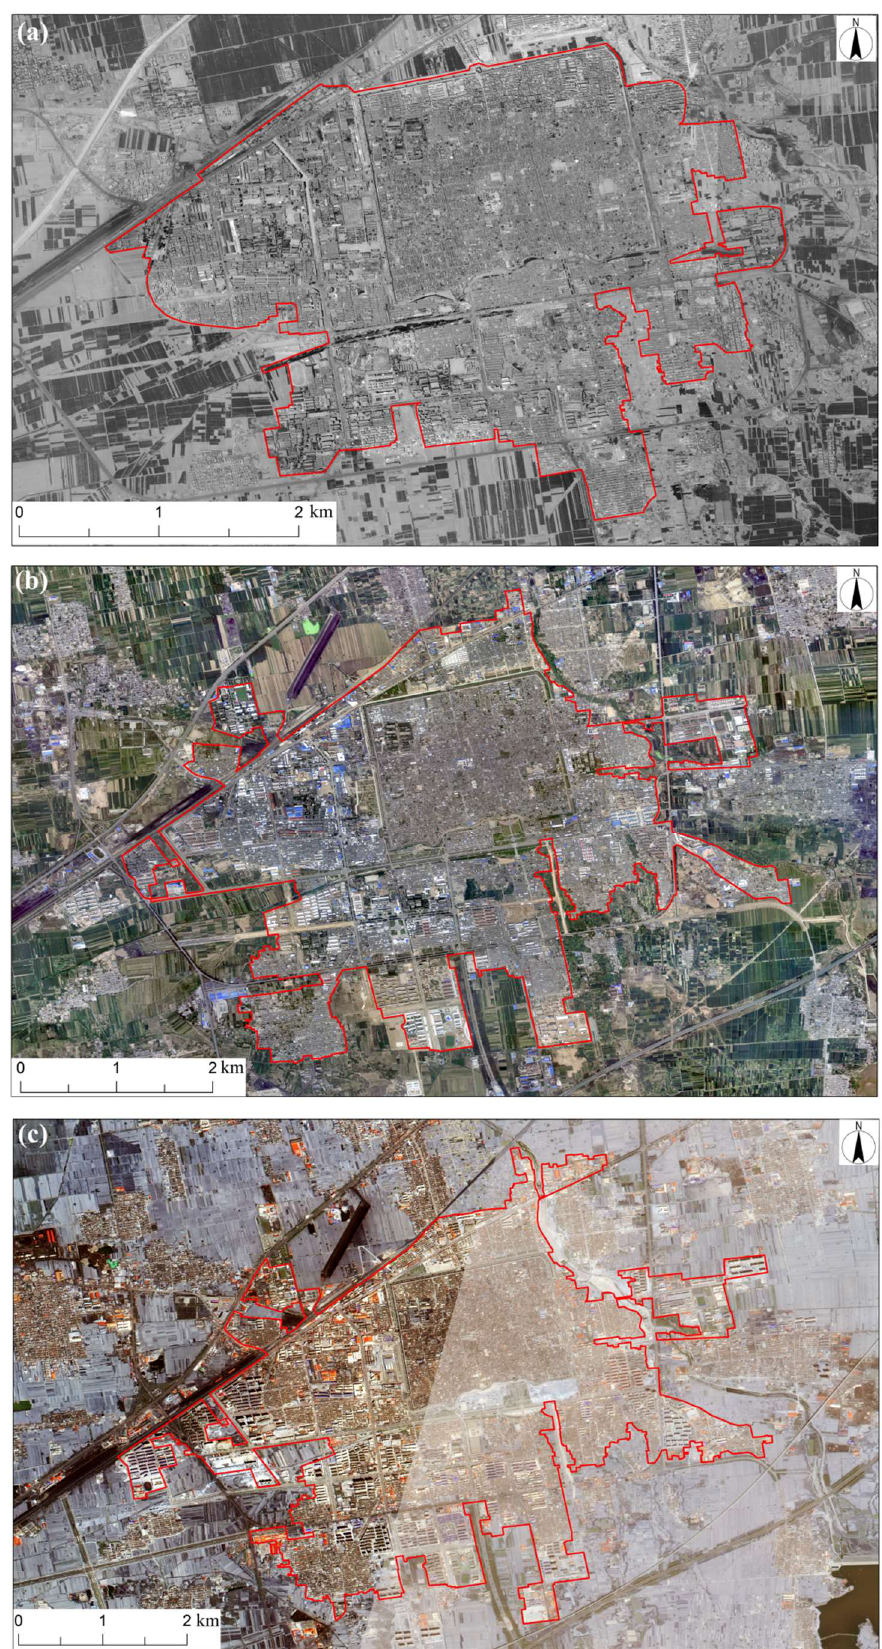
Figure 7. Spatial layout of Pingyao city in 1999 ( a ), 2010 ( b ), 2015 ( c ). (Images provided by Shanxi Institute of Surveying, Mapping and Geoinformation).